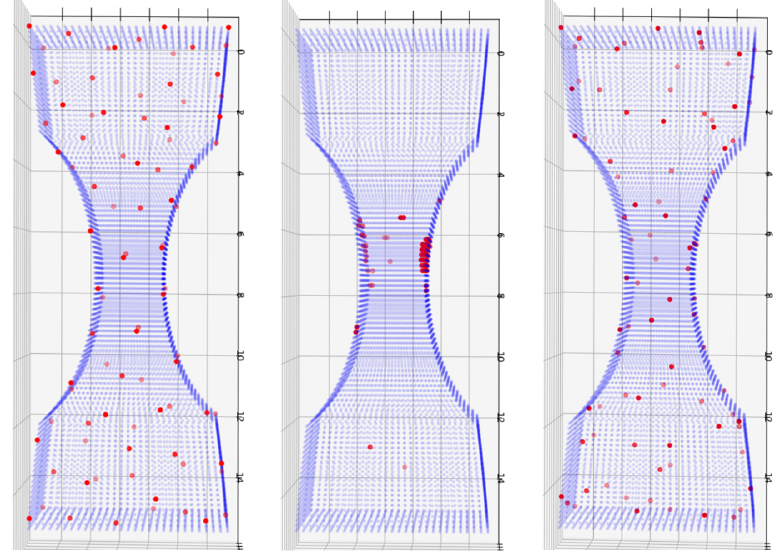
Figure 3. Red dots indicate the selected features. From the left to the right: geometric feature selection, MI-based feature selection, and geostatistical